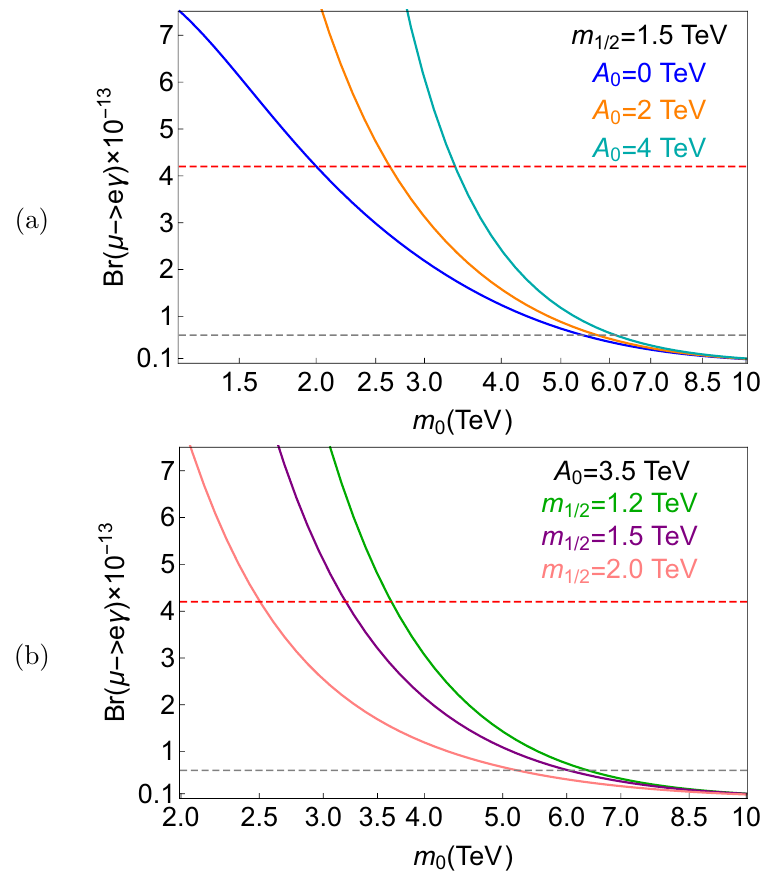
Figure 4 . The branching ratio of (cid:22) e(cid:13) is presented for our SUSY SO(10) framework. We set ! sgn( (cid:22) ) > 0 and tan (cid:12) = 10. In the (cid:12)gure (a) we (cid:12)x m = 1 : 5 TeV and show variations for three 1 = 2 values of A 0 . In the (cid:12)gure (b) we (cid:12)x A 0 = 3 : 5 TeV and show variations in three values of m . 1 = 2 The red horizontal dashed line corresponds to the current upper bound Br ( (cid:22) e(cid:13) ) < 4 : 2 10 (cid:0) 13 ! (cid:2) by the MEG experiment and the gray horizontal dashed line represents the projected sensitivity Br ( (cid:22) e(cid:13) ) < 6 10 (cid:0) 14 by the MEG II experiment [105]. ! (cid:2) Br ( (cid:22) e in Ti) 6 10 (cid:0) 3 Br ( (cid:22) e(cid:13) ) and Br ( ‘ 3 ‘ ) 7 10 (cid:0) 3 Br ( ‘ ‘ (cid:13) i j i j (cid:0) (cid:25) (cid:2) ! ! (cid:25) (cid:2) !